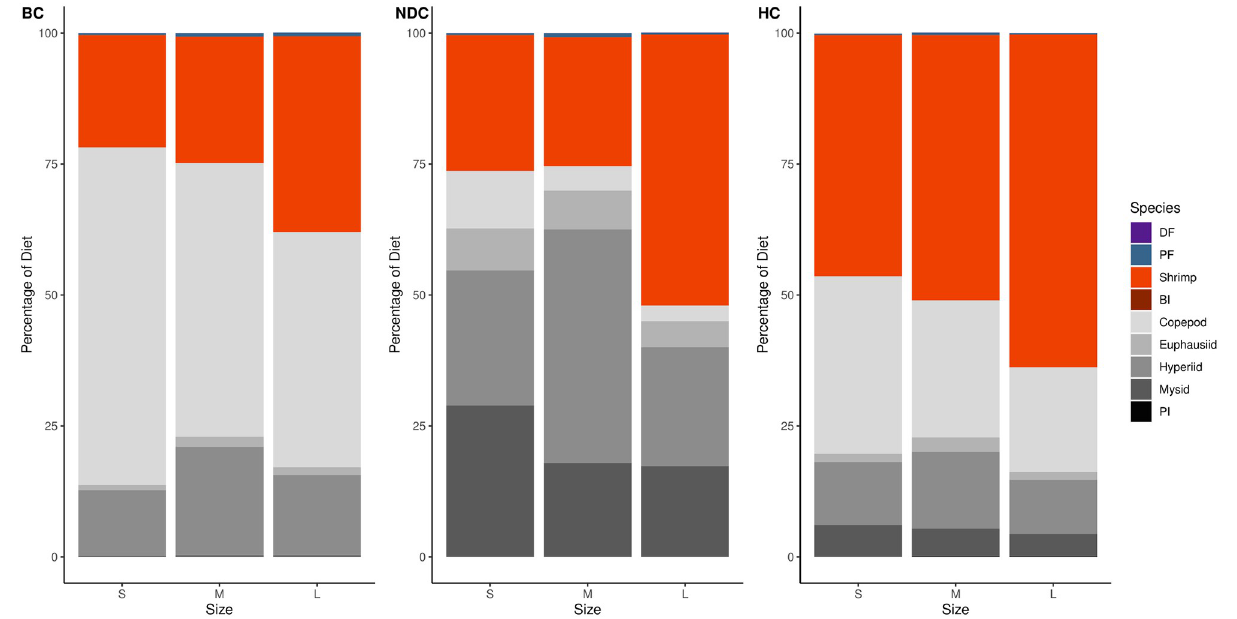
Fig 6. Redfish diet composition percentages as determined from isotope mixing models. This figure is divided by predator size category (S for small, M for medium, L for large, see Table 2) and region (BC for Bonavista Corridor, NDC for Notre Dame Channel, HC for Hawke Channel). Prey taxa abbreviations are defined in Table